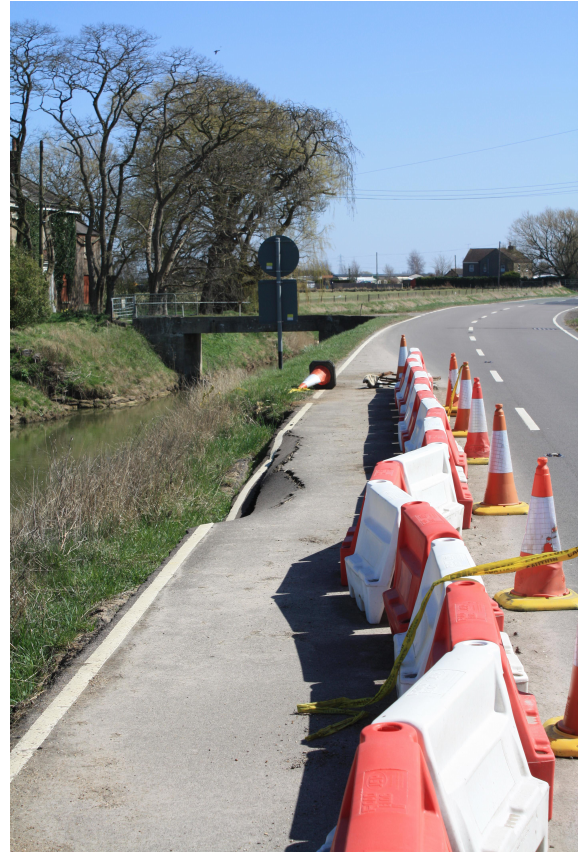
Figure 8. Road embankment instability, B1165 Ravens Bank, Lin- colnshire (photo: O.